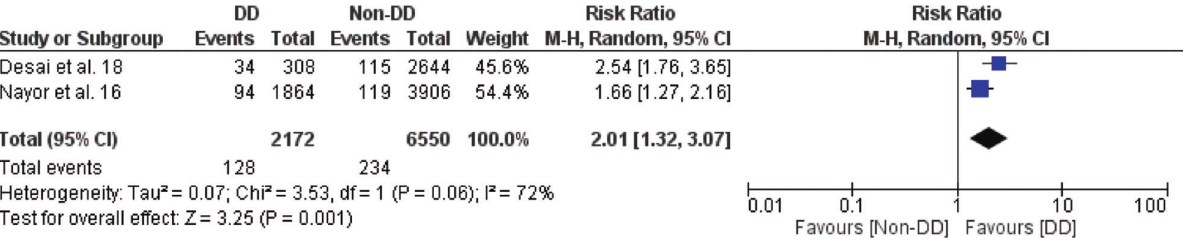
Figure 3.1 - The Risk Ratio and 95% confidence interval (CI) in the cardiovascular events (fatal and non-fatal), for Left Ventricular Diastolic Dysfunction group versus the Control group.